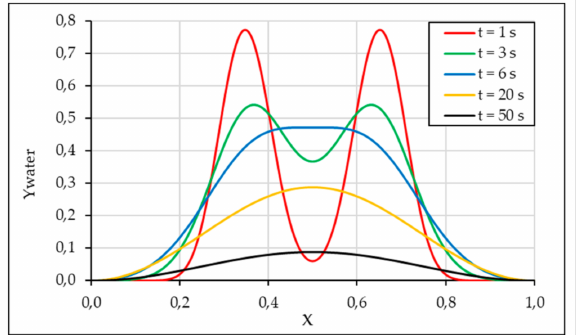
Figure 3. Spatial distribution of Y water at 5 different